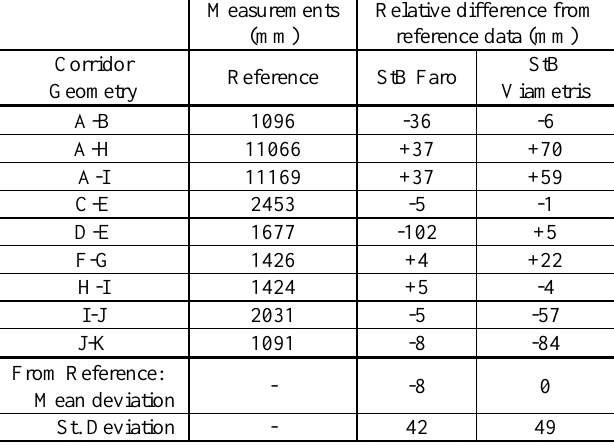
Table 3. Comparison measurements between the corridor reference geometry and that created from Scan to BIM